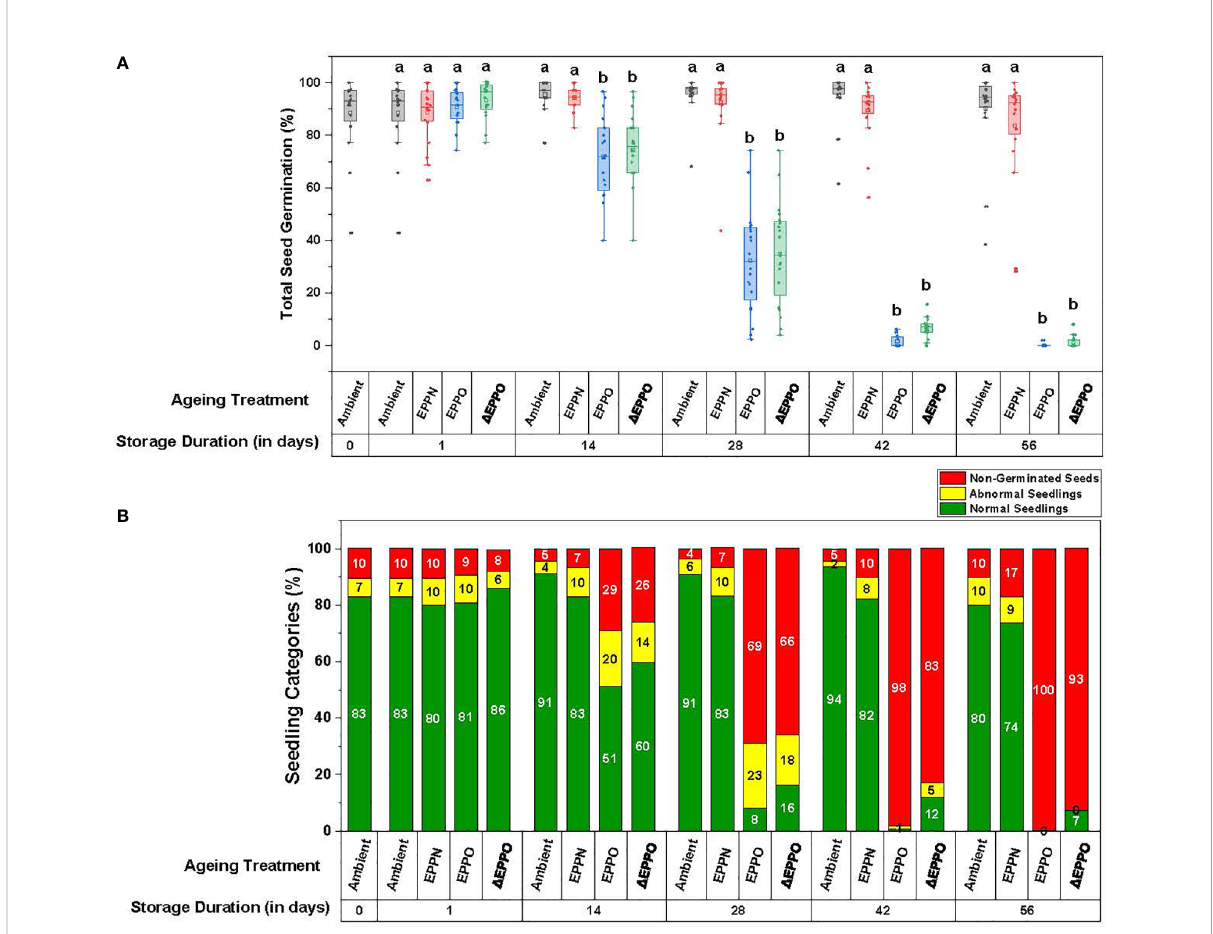
FIGURE 1 Phenotypic variation in seed germination parameters after storage. (A) Total seed germination as the mean for the 20 rice accessions. Different letters above the bars in represent statistically signi fi cant differences ( p <0.05) using Tukey ’ s test. (B) Seedling categories as the mean for the 20 rice